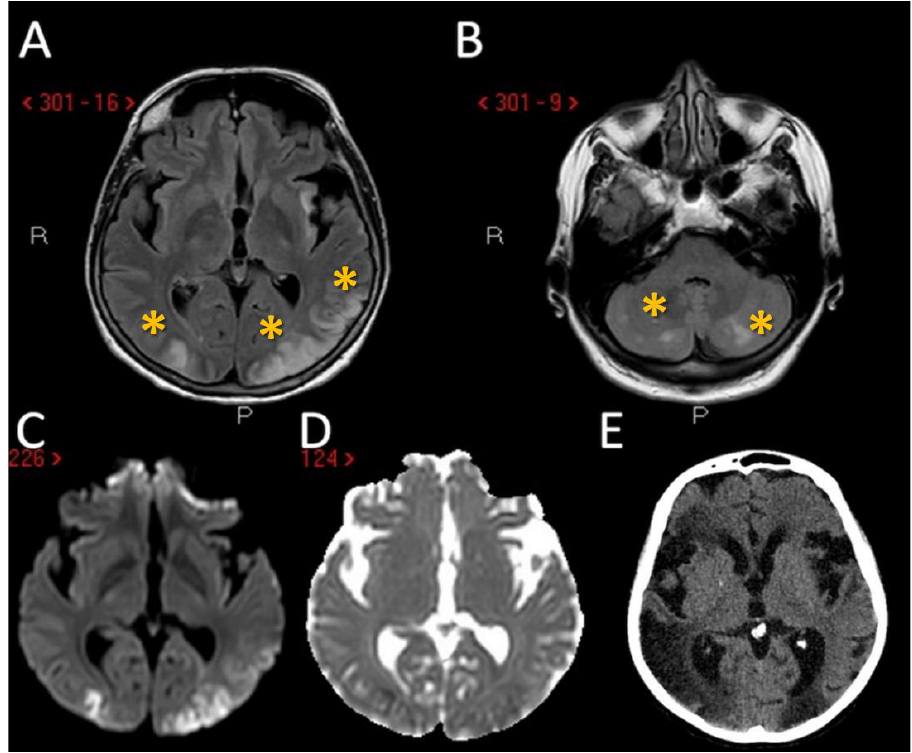
Figure 3. Neuroimaging studies of the third patient. MRI of patient 3 showed the presence of multiple supratentorial ( A ) and infratentorial ( B ) hyperintense lesions (yellow asterisk) with a territorial distribution in A and border zone pattern in B (axial FLAIR sequences) with DWI and ADC pattern suggesting acute ischemic lesions with a metachronous timing pattern ( C , D ). In the follow-up CT performed 7 days later it is evident the increased number of ischemic lesions, in particular on the right hemisphere ( E